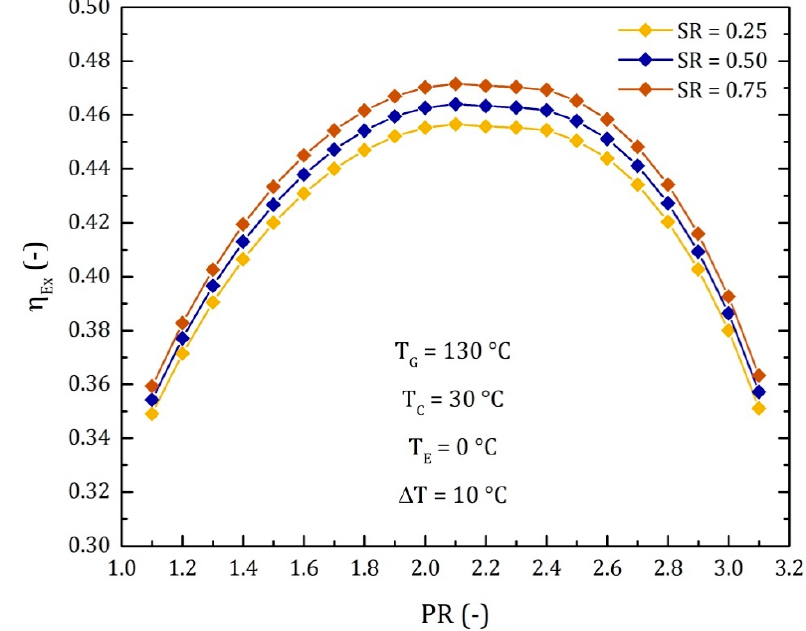
ff erent values of